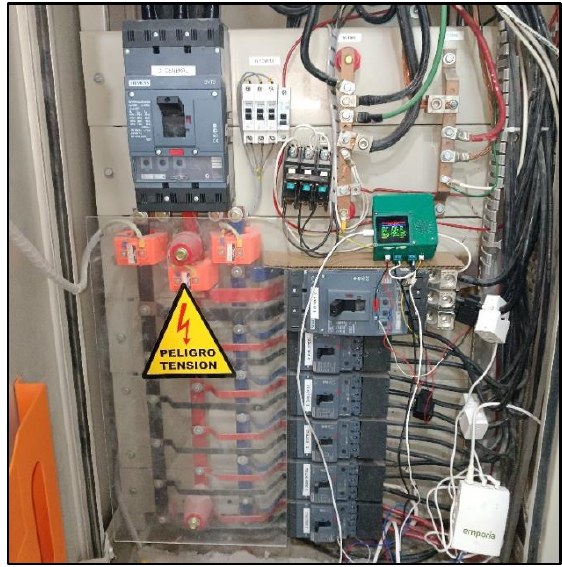
Figure 10. Installations in the electrical distribution box.